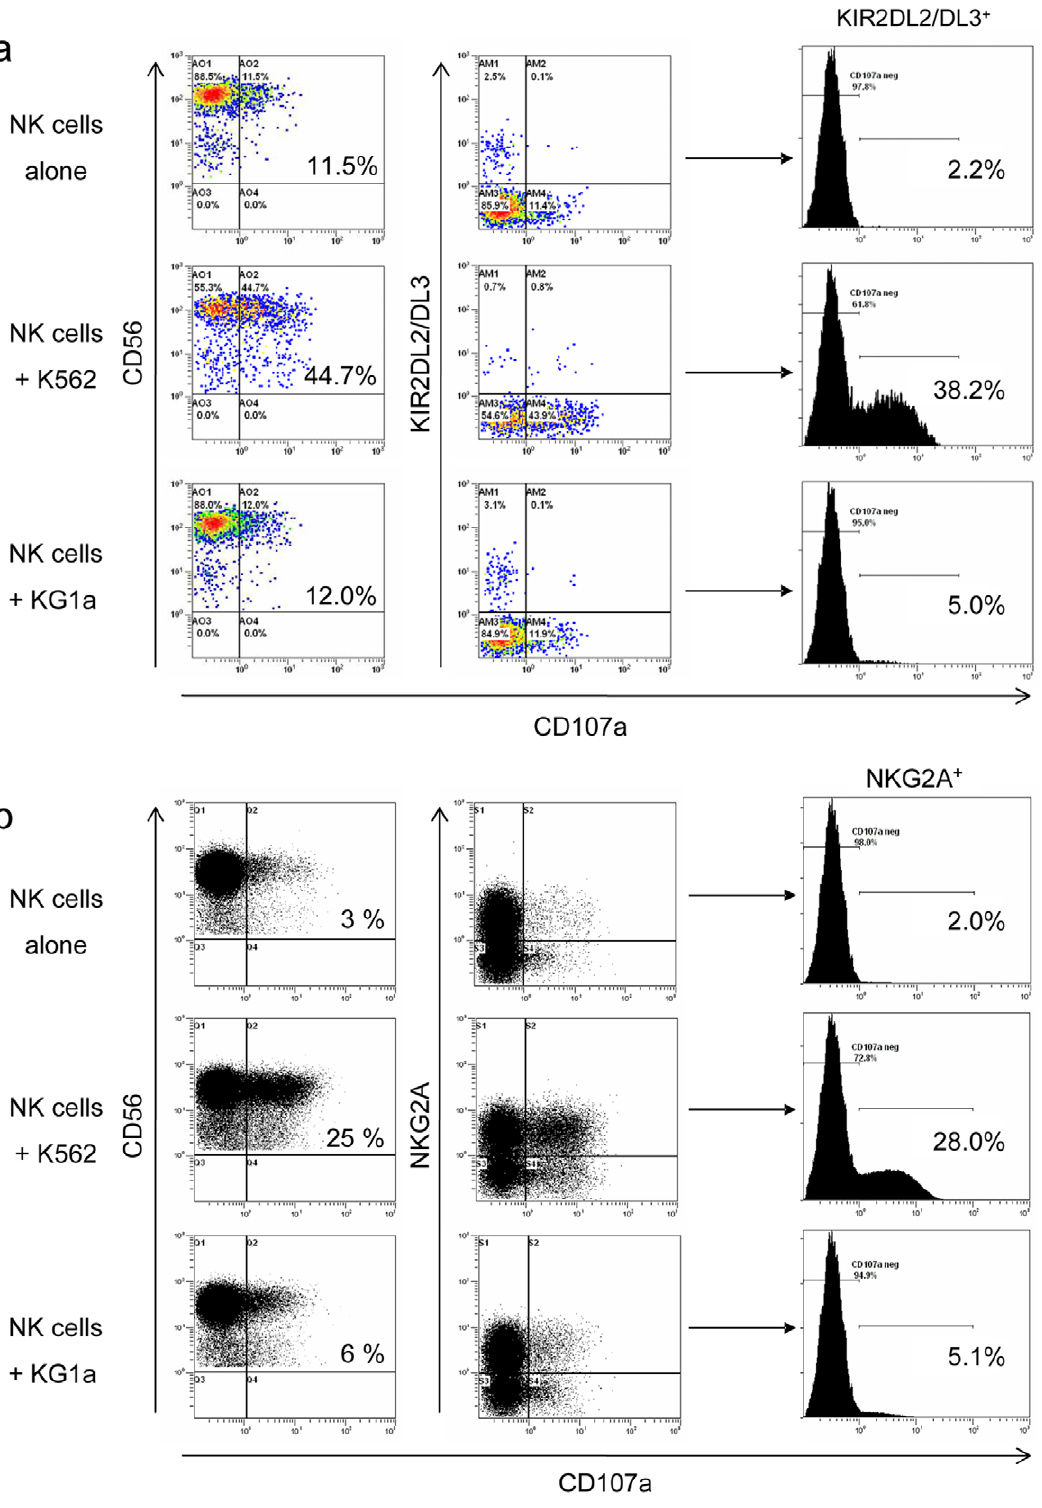
Figure 5. Responsiveness of exvivo -generated KIR + and NKG2A + NK cells to MHC class I-deficient target cells. Ex vivo -generated NK cells using Method II with GBGM were incubated alone, or 18 hours with MHC class I-negative K562 or MHC class I-expressing KG1a cells at an E:T ratio of 1:1. Cells were then stained for CD56, CD3, KIR or NKG2A, and the degranulation antigen CD107a. ( a ) Degranulation of total CD56 + CD3 2 NK cells and KIR2DL2/DL3 + NK cell subset expanded for 5 weeks from CD34 + UCB cells. Density plots are gated on CD56 + CD3 2 NK cells and the histogram plots show the CD107a degranulation of the KIR2DL2/DL3 + NK cells. ( b ) Degranulation of total CD56 + CD3 2 NK cells and NKG2A + NK cell subset expanded for 6 weeks from CD34 + UCB cells. Density plots are gated on CD56 + CD3 2 NK cells and the histogram plots show the CD107a degranulation of the NKG2A + NK cells.